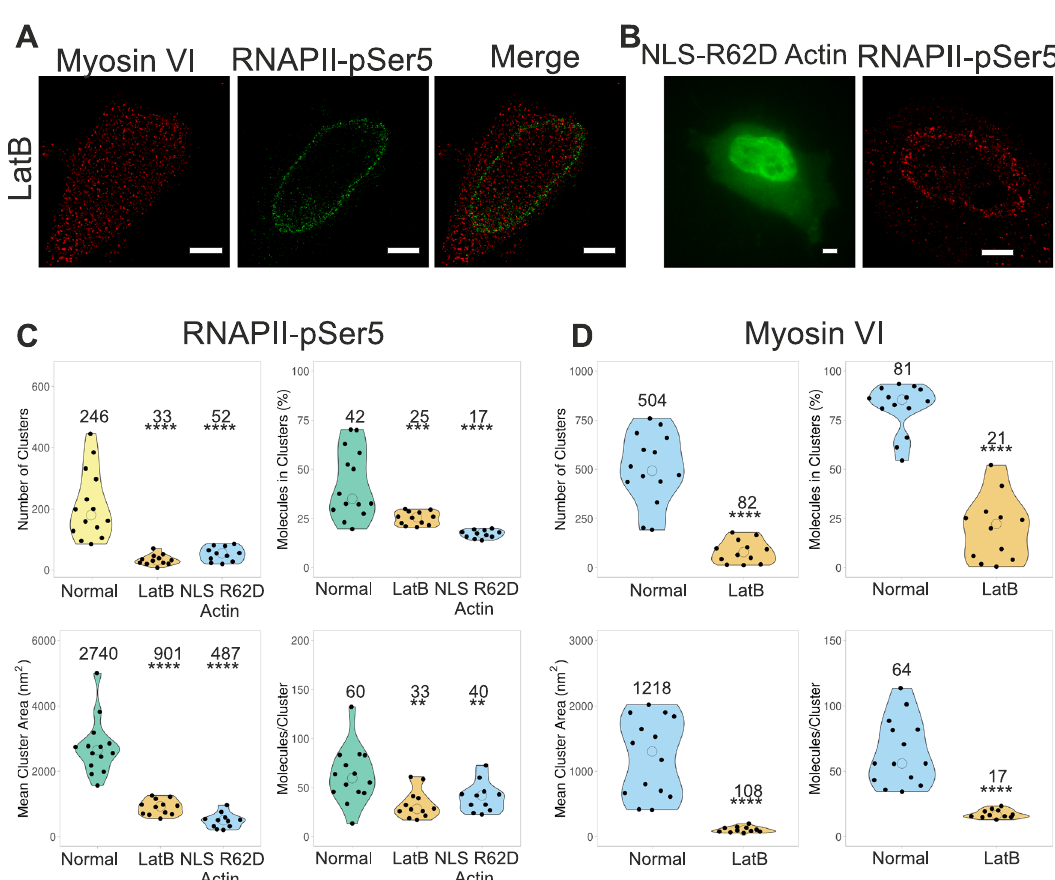
Fig. 4 Impact of nuclear actin upon the organisation of RNAPII. A Example STORM render image of myosin VI and RNAPII-pSer5 following treatment with Latrunculin B (LatB), as described in the methods (scale bar 2 μ m). Further wide fi eld example images are shown in Supplementary Fig. 13D. B (left) Example wide fi eld image of YFP-NLS-R62D actin following transfection. (right) Example STORM render image of RNAPII-pSer5 following transfection of YFP-NLS-R62D actin (scale bar 2 μ m) WT YFP-NLS actin control is Supplementary Fig. 13E. C Cluster analysis of RNAPII-pSer5 nuclear organisation following treatment with LatB ( n = 12) or transfection with YFP-NLS-R62D Actin ( n = 11). D Cluster analysis of myosin VI nuclear organisation following treatment with LatB ( n = 12). Individual data points correspond to the average value for a cell ROI. The values represent the mean from the ROIs for each condition (Only statistically signi fi cant changes are highlighted ** p < 0.01; *** p < 0.001; **** p < 0.0001 by two-tailed t test compared to normal (not quanti fi ed) (Fig. 5E). These fi ndings are consistent with the previous reports using this technique 36 . To further investigate RNAPII dynamics, the total numbers of static (<0.1 µm 2 s − 1 ) and mobile (>0.1 µm 2 s − 1 ) RNAPII molecules were plotted as a ratio (Fig. 5F). Under normal conditions, just over half of the RNAPII population (52%) was static, probably corresponding to molecules con fi ned at sites of transcription activation.